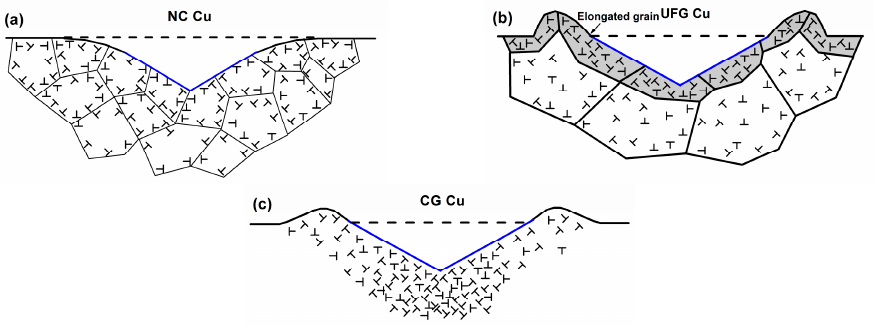
Figure 8. Schematic illustrations of local GB structures and dislocation distribution in the NC ( a ); UFG ( b ); and CG ( c ) Cu underneath the indenters, where “T” represents dislocation. UFG ( b ); and CG ( c ) Cu underneath the indenters, where “T” represents